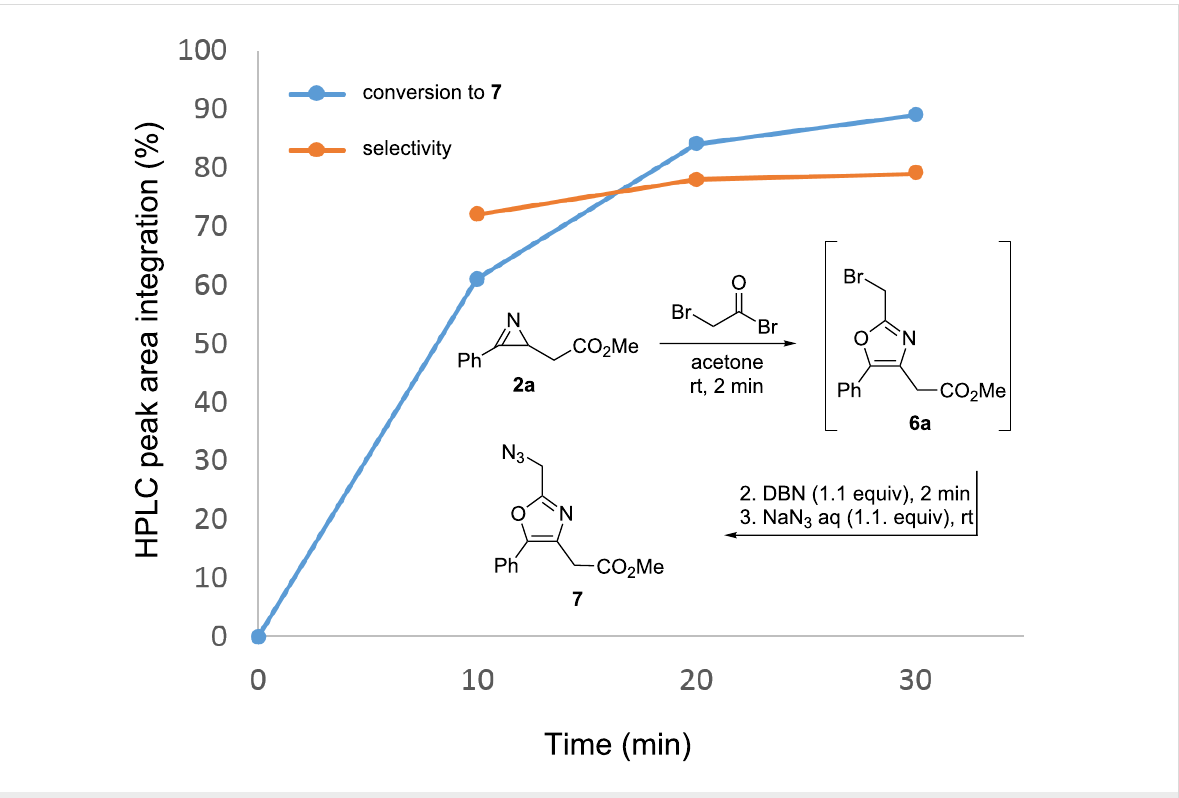
Figure 2: HPLC monitoring of the formation of 2-(azidomethyl)oxazole 7a .